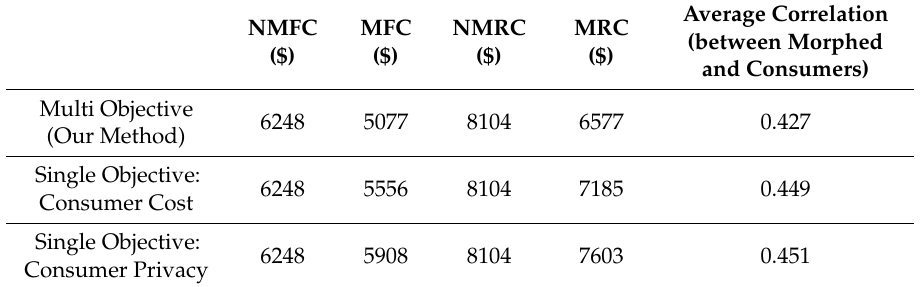
Table 3. Cost ($) and privacy (correlation) measure values computed for Scenario 2 (Seven consumers).